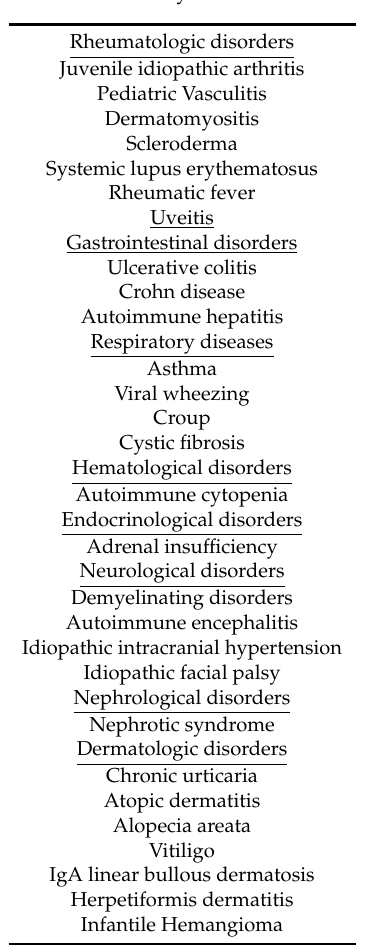
Table 1. The most common indications of systemic corticosteroids in pediatric